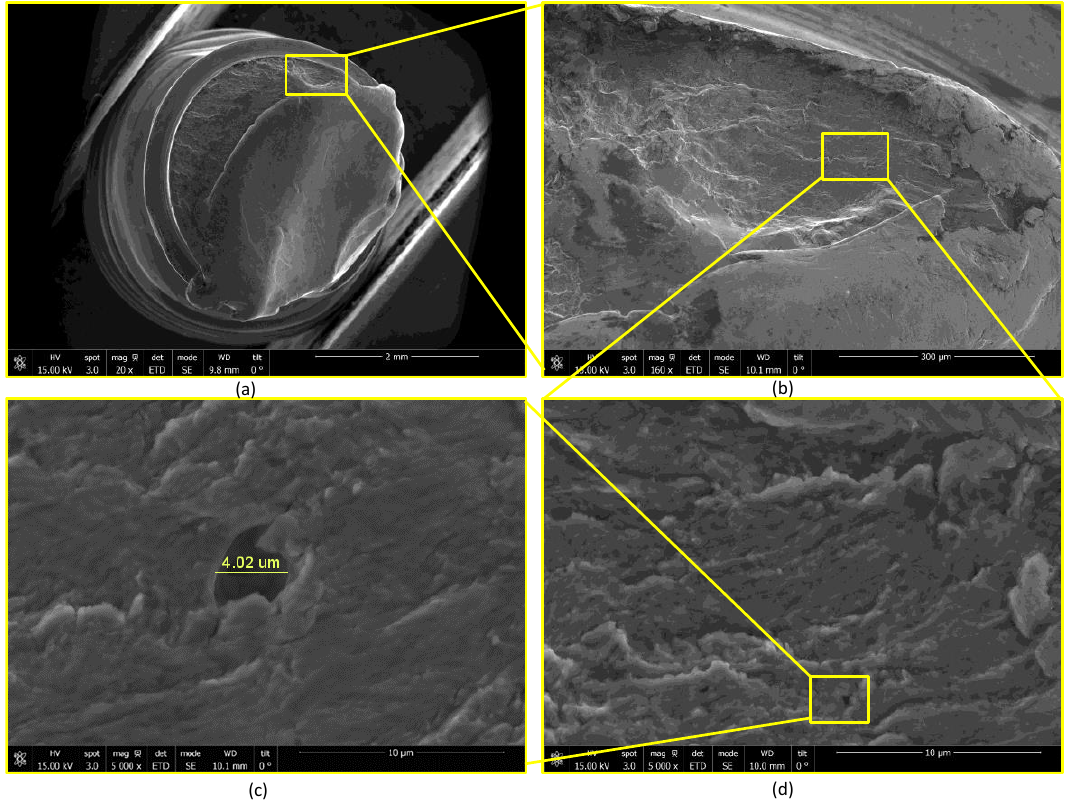
Figure A10. ( a ) Montage of SEM images showing the fracture surface of the cortical screw (CS4) ( b ) flattening from rubbing.